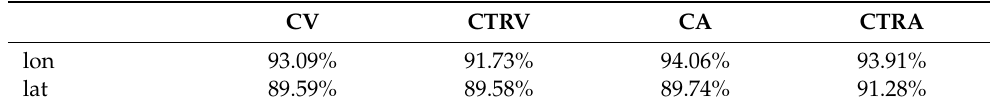
Table 7. Accuracy of the models.